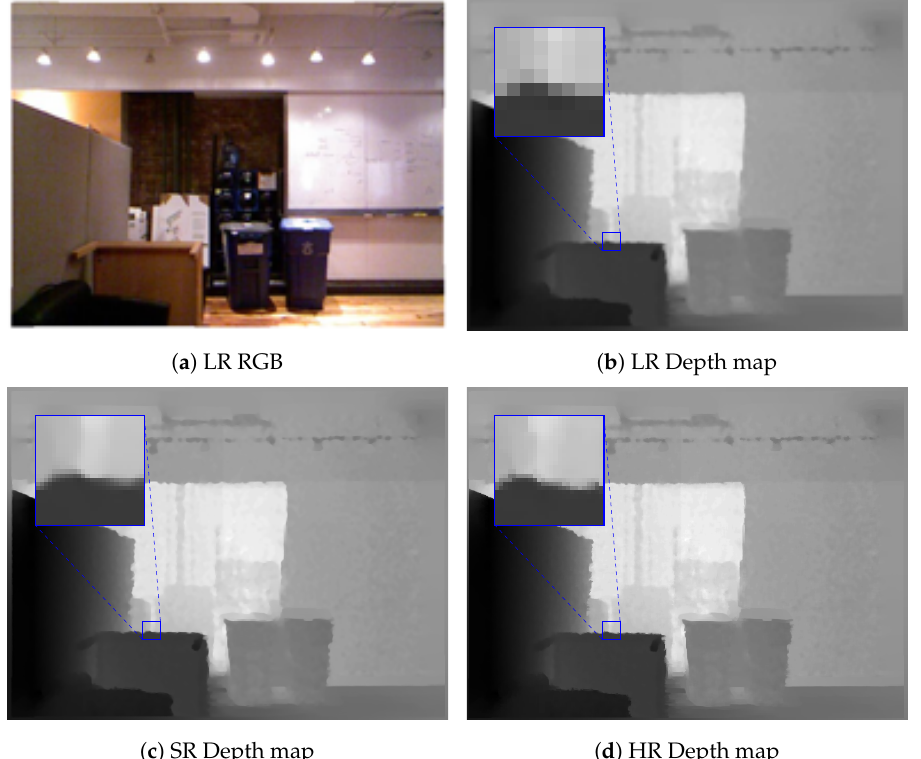
Figure 13. Visual comparison of the DSR on the NYUv2 dataset [53] with a scale factor of 3.3.